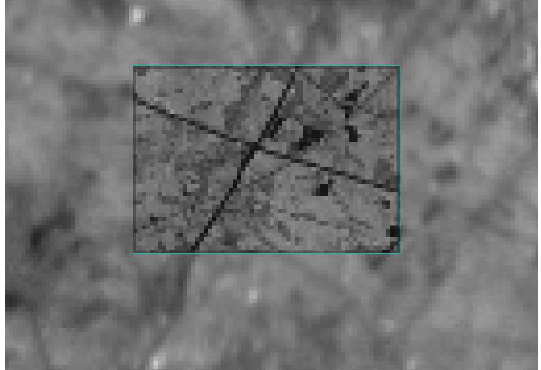
Figure 7. 60 m resultant images of July 24